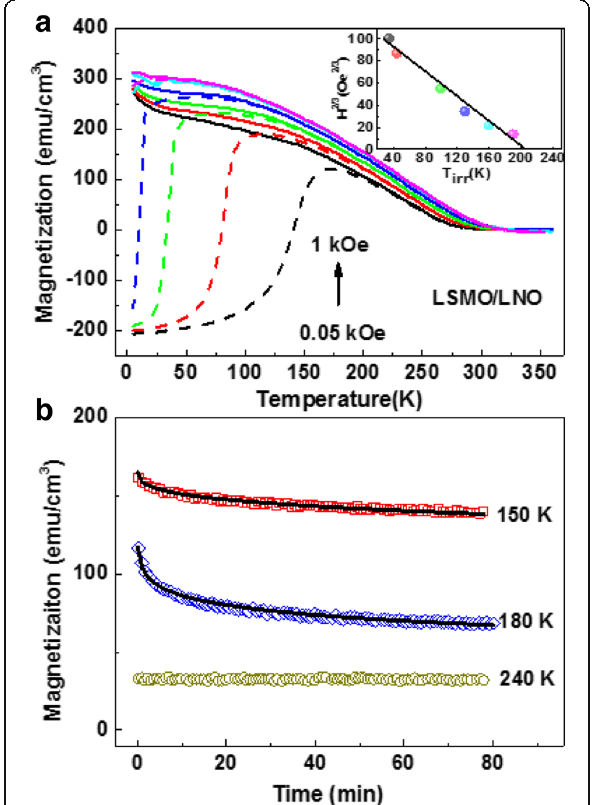
Fig. 3 a M – T curves of the LSMO/LNO bilayer heterostructure are measured under different external magnetic fields, H = 0.05 ( black ), 0.1 ( red ), 0.2 ( green ), 0.4 ( blue ), 0.8 ( light blue ), and 1 ( purple ) kOe, respectively. The solid and dashed lines are the FC and ZFC curves. The corresponding plots of H 2/3 versus T irr and linear fitting to Eq. (1) are shown in the inset. b Time dependence of the thermal remnant magnetization under the cooled magnetic field of 0.1 kOe and linear fitting to Eq.